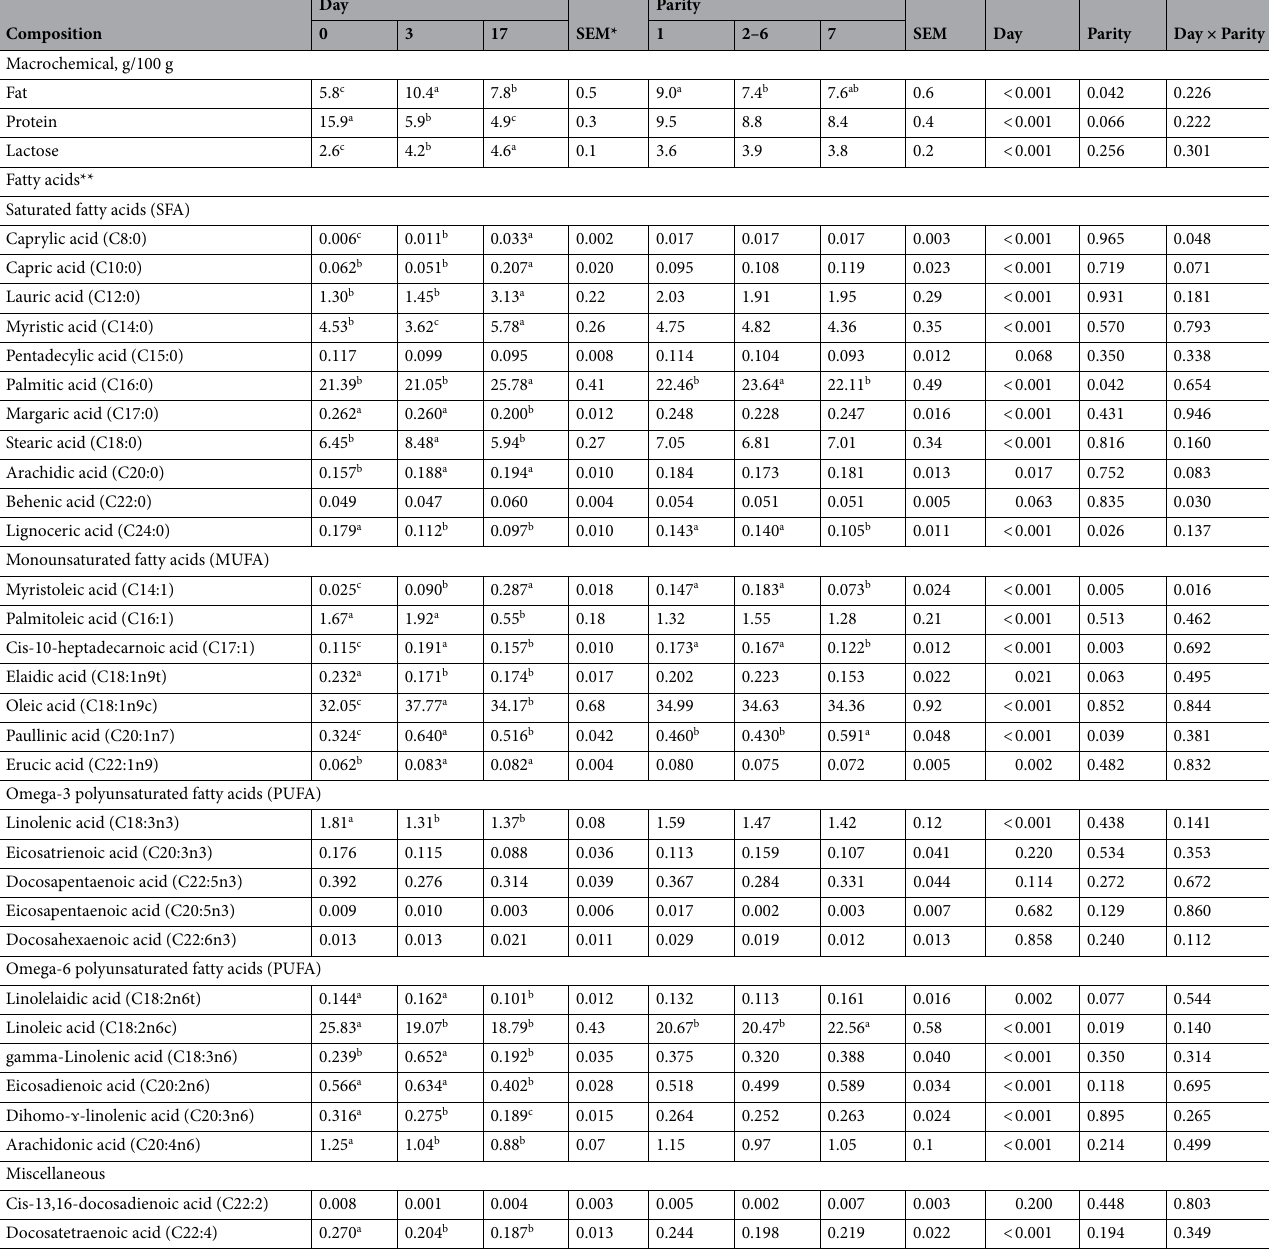
Table 1. Effect of lactation stage and parity number on macrochemical composition and fatty acid profiles of sow colostrum and milk. abc Different superscript letters within row indicate significant differences ( P <